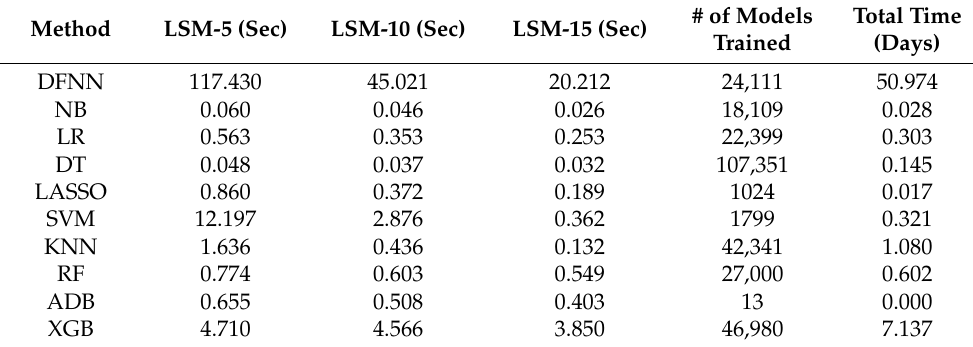
Table 5. Experiment time per model per dataset, number of models trained, and total